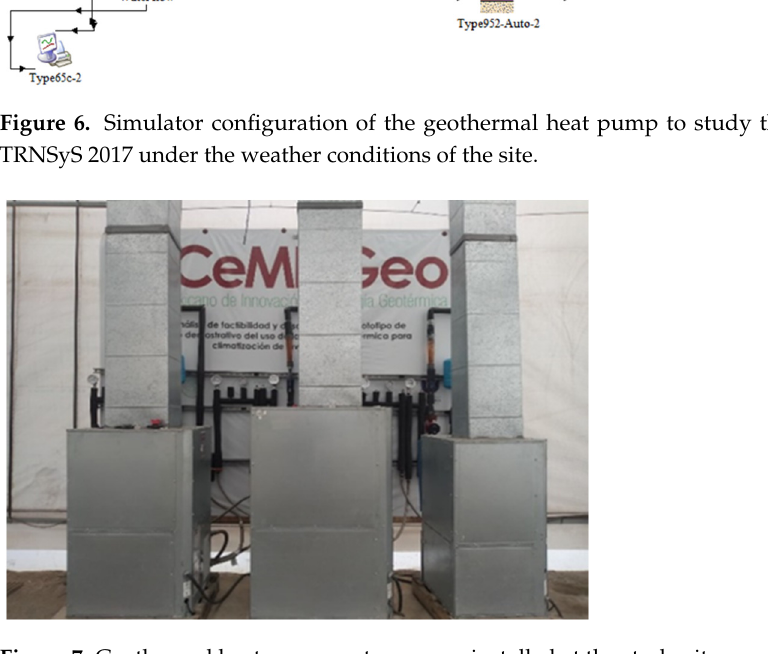
Figure 6. Simulator configuration of the geothermal heat pump to study the performance with TRN- SyS 2017 under the weather conditions of the site.